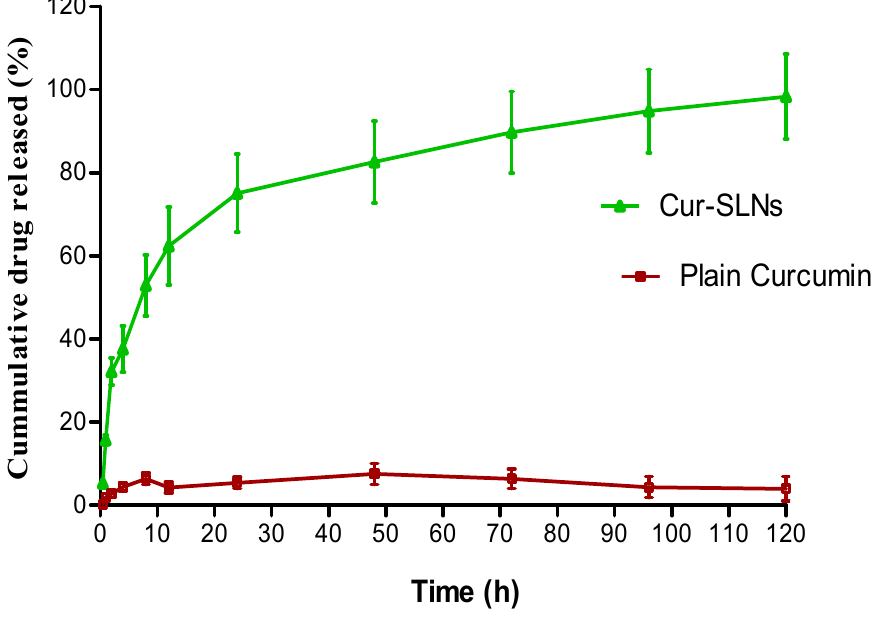
Figure 3. Cumulative % release of curcumin from Cur-SLNs in PBS (0.01 M, pH 7.4) and plain curcumin. Initial burst effect followed by sustained release effect up to 120 h.